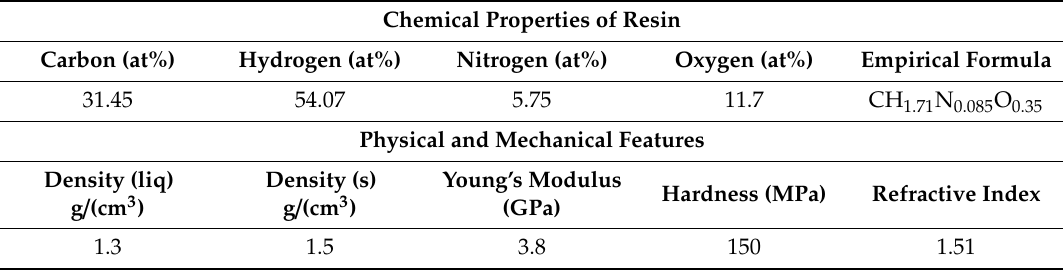
Figure 2. ( a ) Schematic of a digital light processing (DLP) system [53]; ( b ) 3D printing process in progress; ( c ) MiiCraft 3D printer. Table 2. The elemental composition and fundamental features of the IP-S resin [54].